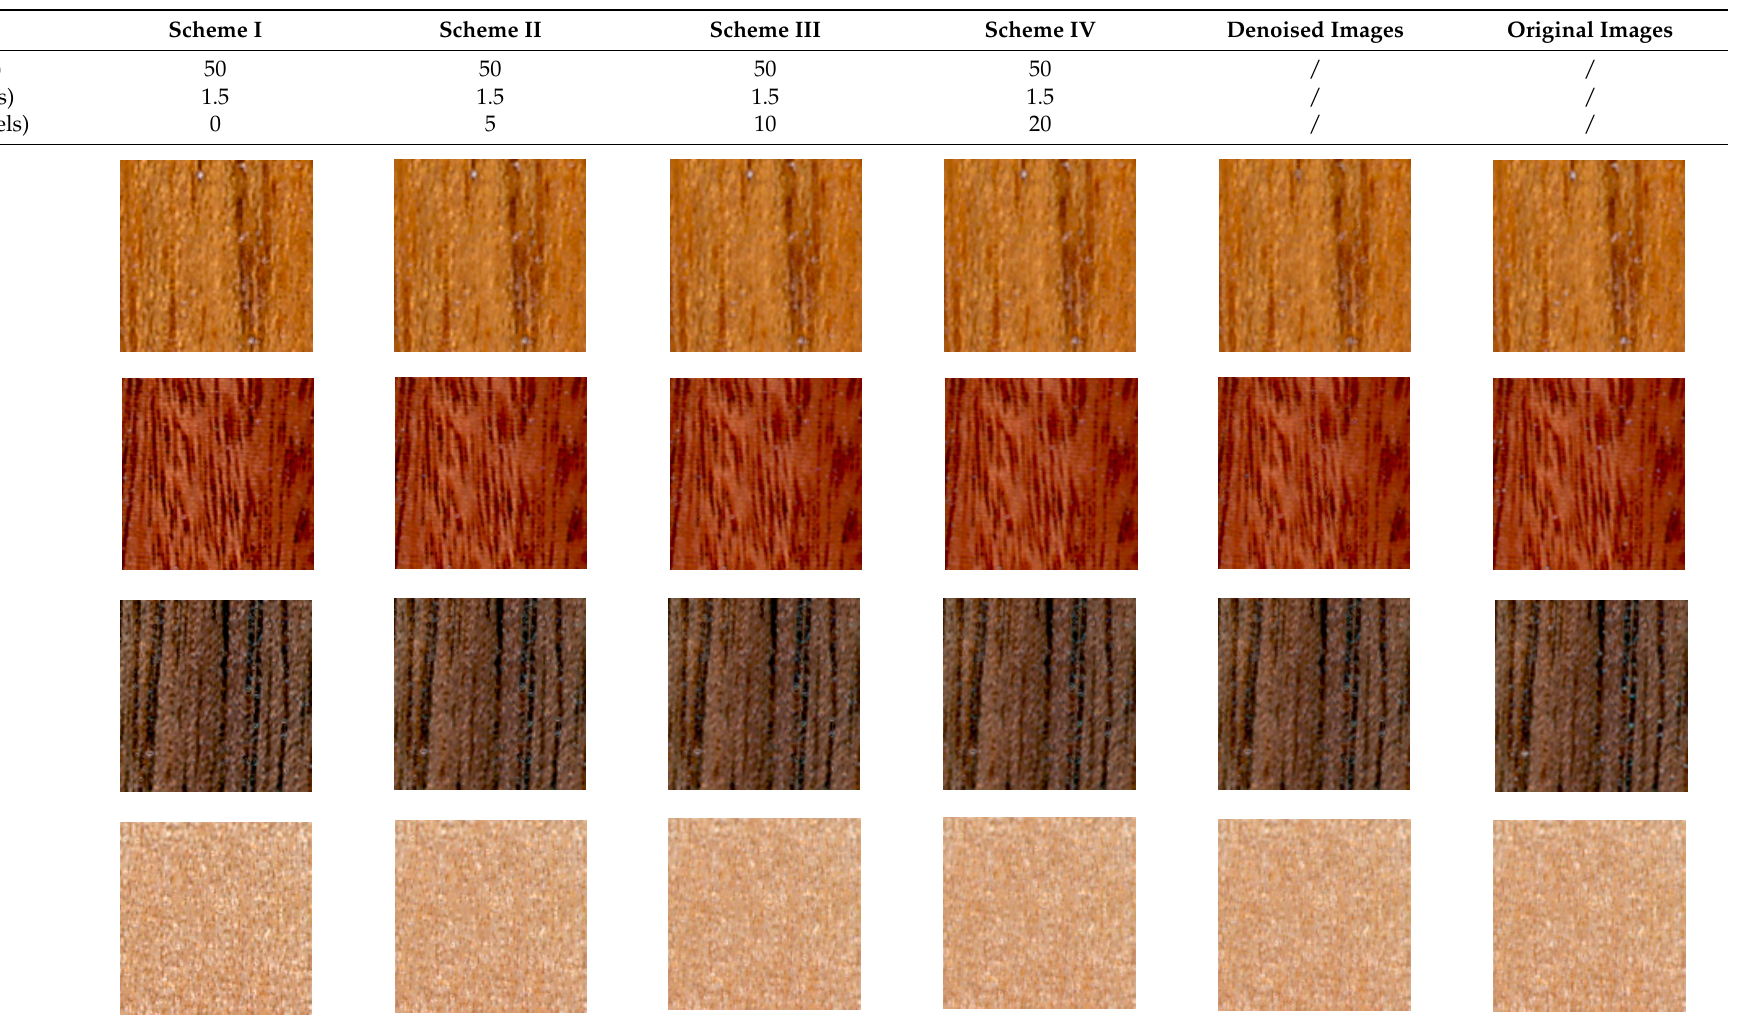
Table 5. Parameter settings and sharpening effects of Unsharp Mask .